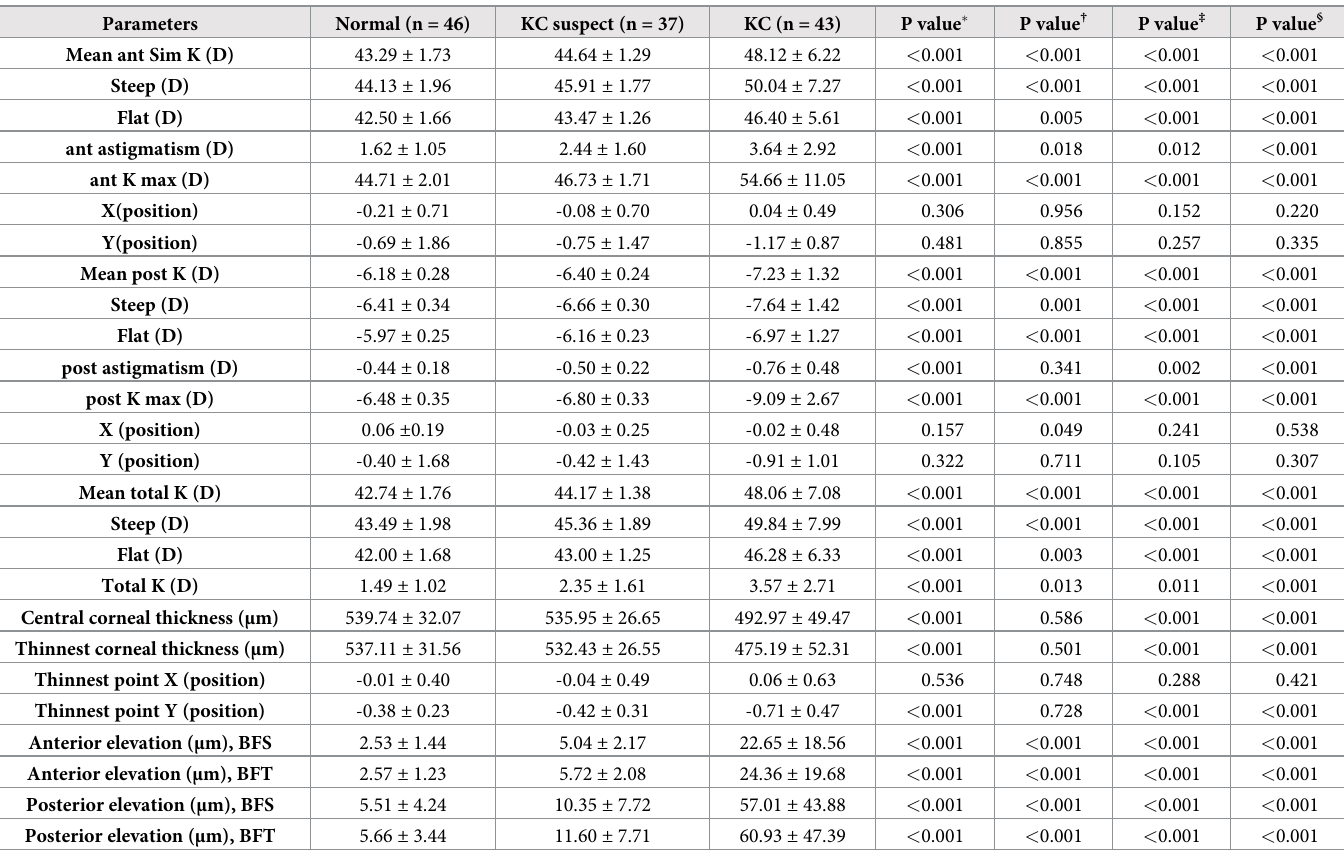
Table 2. Anterior segment parameters of ANTERION in three